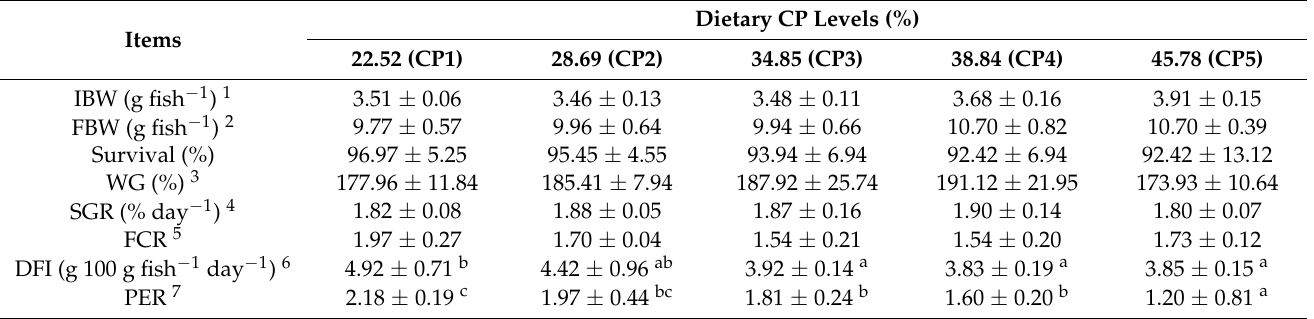
Table 2. Growth performance and feed utilization of juvenile K. punctatus fed diets containing different CP